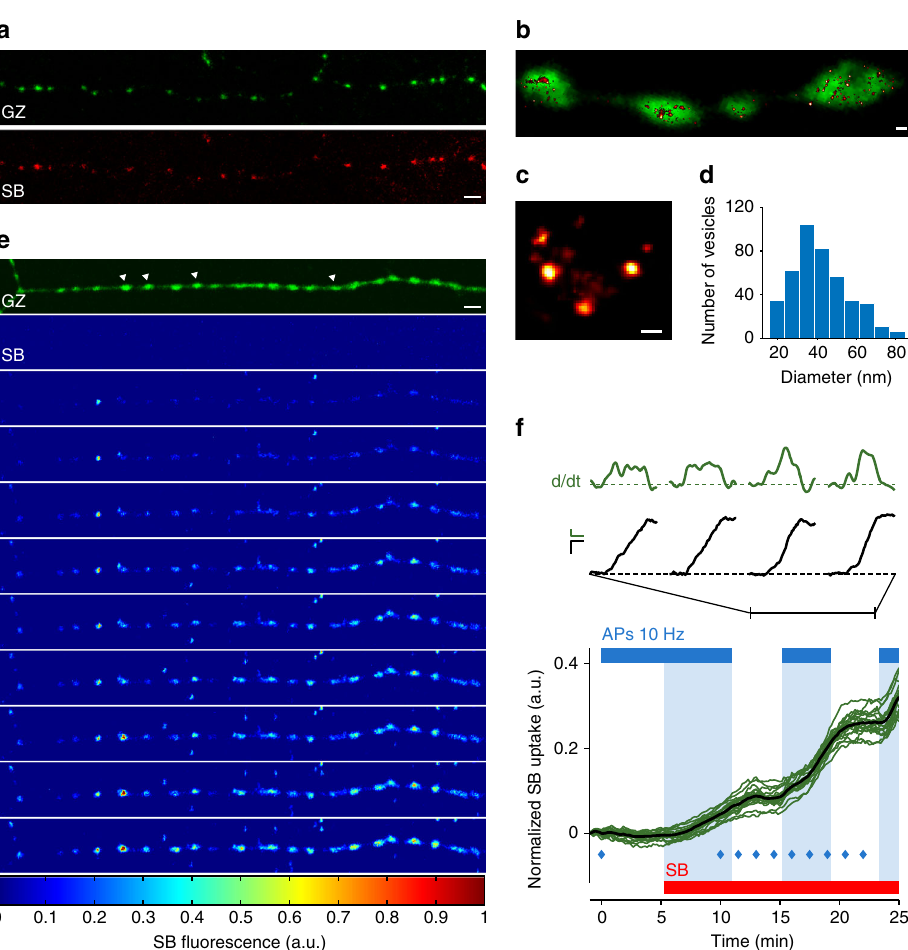
Fig. 2 Synaptic expression of SynaptoZip and activity-dependent uptake of SB. a Presynaptic boutons expressing GZ (green) in acute hippocampal slices (Schaffer collateral, CA1). Slices were bathed with SB (red; SB 5 nM, 5 min, 24 °C, 30 mM isosmotic KCl). b – d Super-resolution microscopy of cultured CA3-CA1 hippocampal synapses. b Presynaptic boutons expressing GZ (green), with superimposed labeled synaptic vesicles, after spontaneous uptake of SB (hot red LUT; SB 5 nM; 60 min incubation, 37 °C). c Magni fi ed view of synaptic vesicles loaded with SB. d Analysis of vesicles diameter following spontaneous uptake of SB ( N = 428 SB-labeled vesicles from 24 synapses; 41.2 ± 16.2, mean ± SD). e , f Time-lapse imaging of SB uptake (SB 5 nM, 24 °C; color map, LUT at the bottom) in a group of boutons along a single axon (cultured hippocampal CA3 – CA1 neurons), before and during trains of presynaptic action potentials (APs). In f , green lines are normalized SB uptake time series for N = 18 individual boutons (same experiment as in e ; thick black line is the average SB uptake trace; blue diamonds correspond to time frames shown in e ). The red bar refers to the presence of SB 5 nM in the bath, the blue bar indicates the stimulation epochs (trains of 10 AP at 10 Hz inter-leaved with 4 s pauses). Pale blue areas signal the occurrence of stimulation when SB is present. On top of graph, expanded traces to illustrate SB uptake (black lines; scale bar: 0.05 a.u. vs. 2 min) from 4 out of the 18 boutons (indicated by white arrowheads in e , GZ), and its rate (green lines, time derivative; scale bar: 0.05 a.u. h − 1 vs. 2 min), during the second stimulation epoch. Notice that, despite the common trend, each synapse shows its own SB uptake dynamics. Scale bars: 4.11 µ m ( a , e ), 400 nM ( b ), 40 nM ( c